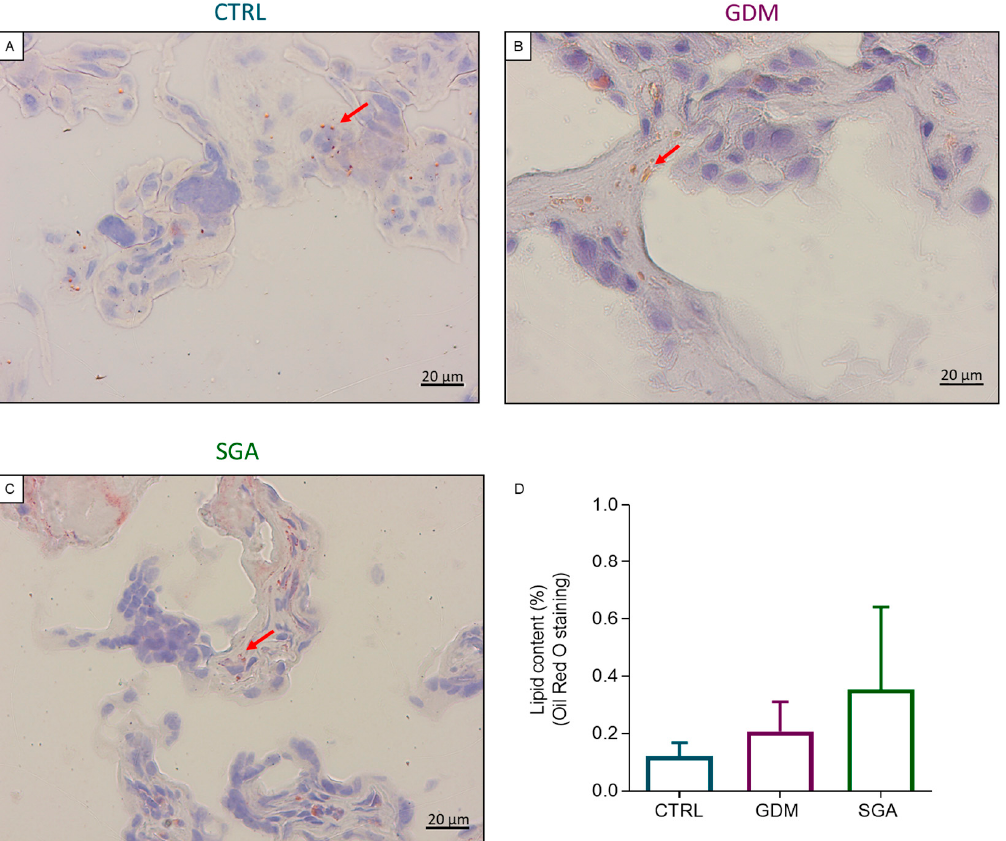
Figure 6. Lipid content analysis through histology in the three experimental groups. Representative histological images showing the lipid droplets (red arrows) within the CV sections ( A – C ). Analysis of lipid content in CV sections using Oil Red O staining ( D ). Bars represent lipid content in the three conditions expressed as mean ± SD of five independent samples ( n = 5). CTRL: control group (blue), GDM: gestational diabetes mellitus (purple), SGA: small-for-gestational-age (green).